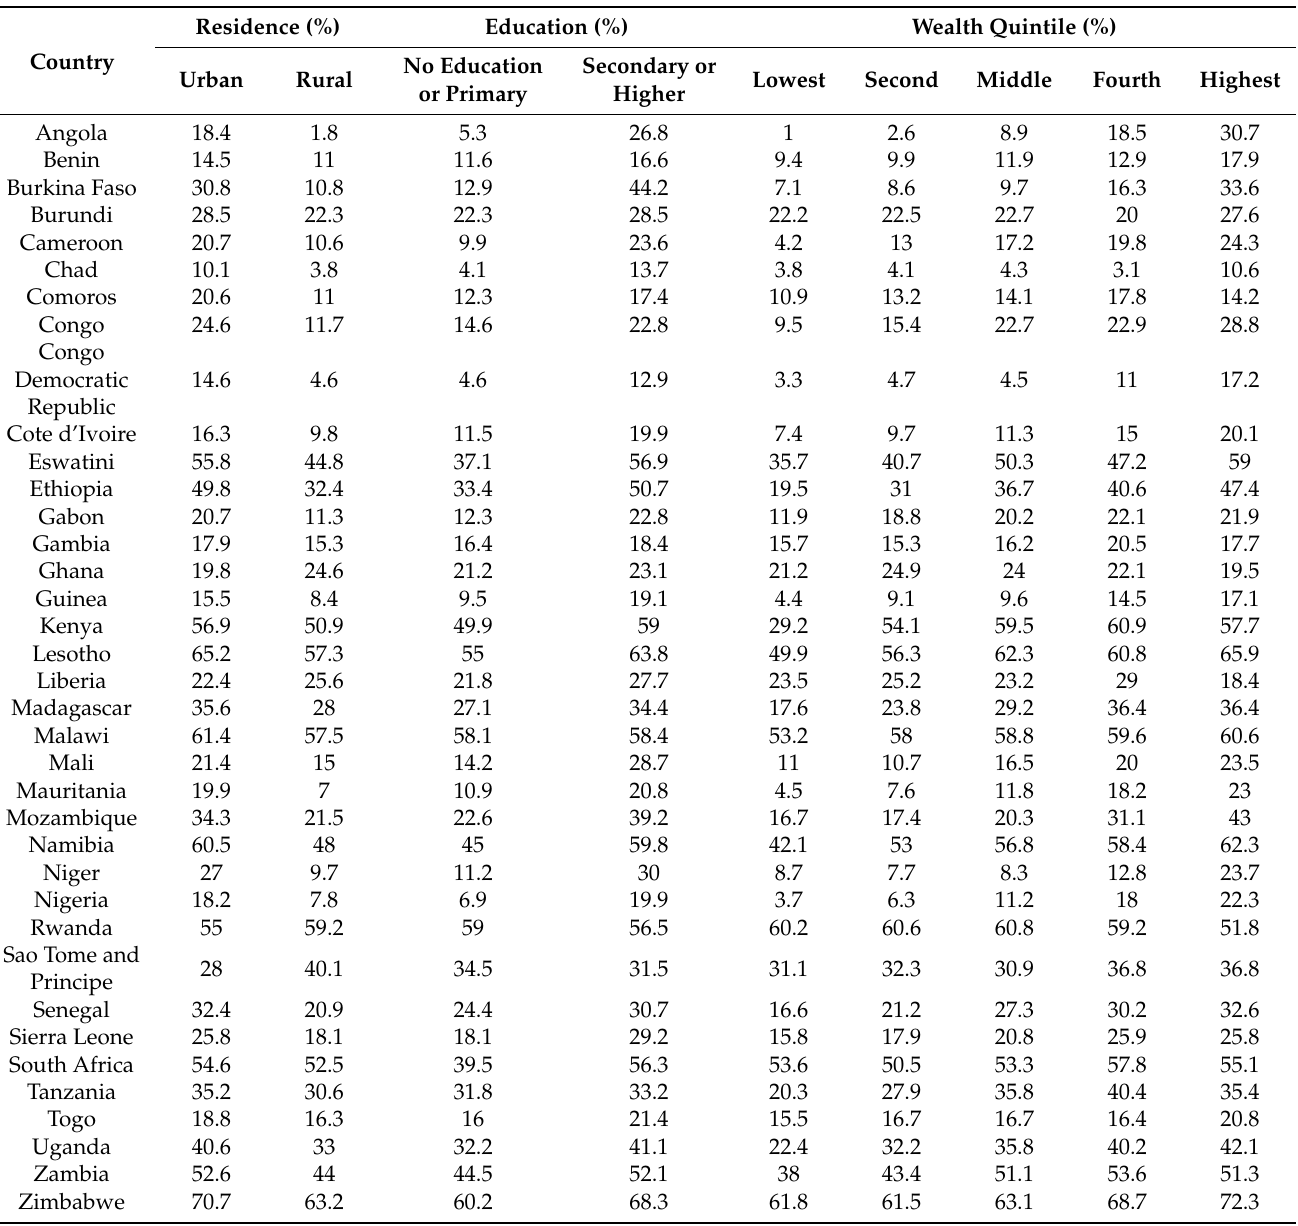
Table 3. Distribution of currently using any modern method of contraception among married women in sub-Saharan